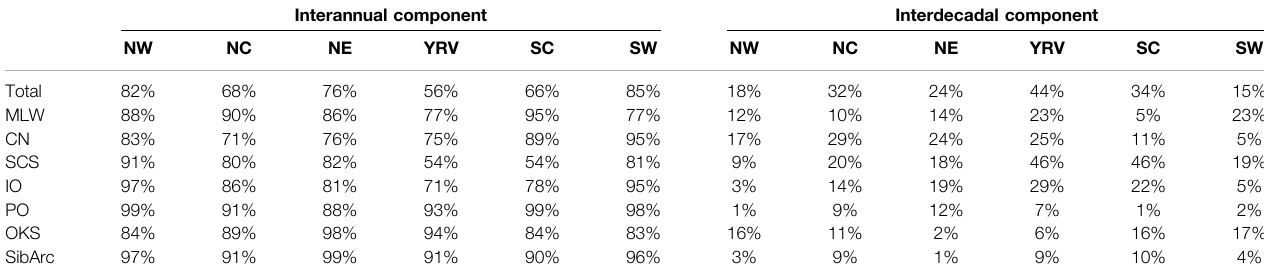
TABLE 1 | Explained variances of summertime total and source precipitation in different regions by the interannual and interdecadal component. Interannual component Interdecadal component